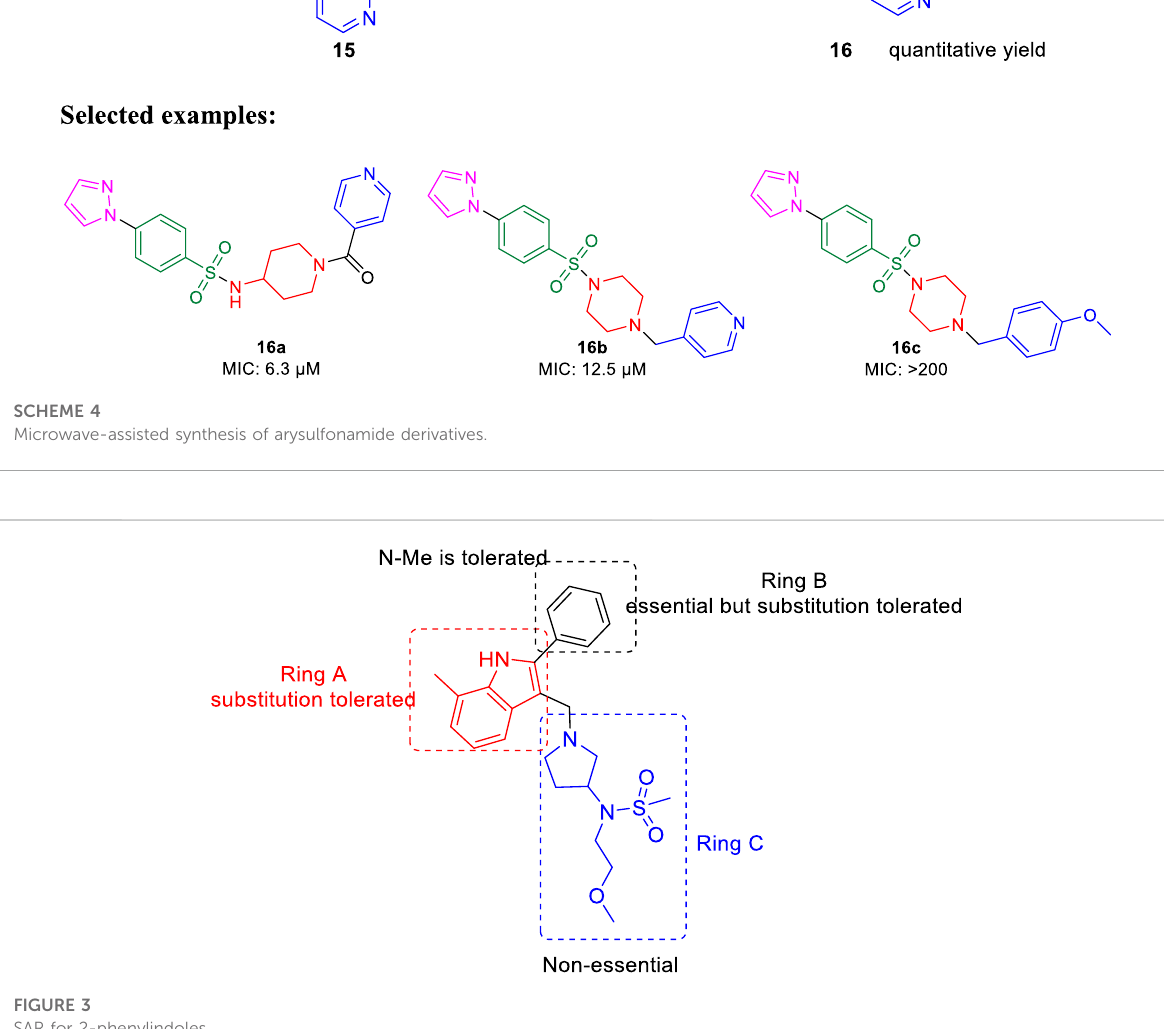
FIGURE 3 SAR for